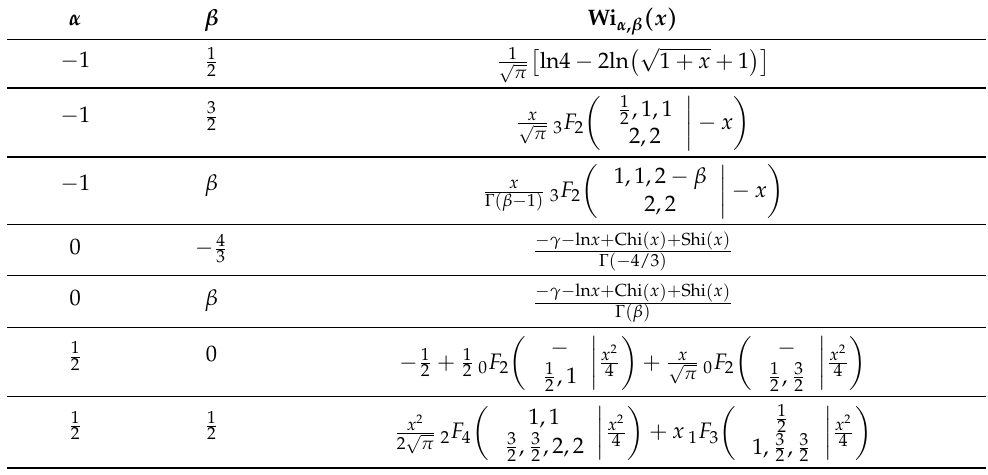
Table 10. The integral Wright functions Wi α , β derived for some values of parameters α and β by using